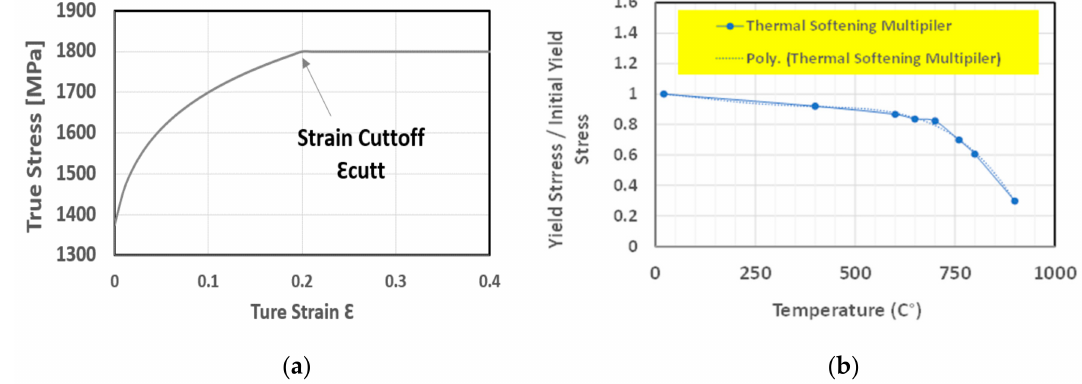
Figure 5. Inconel 718 Parameters for finite element model ( a ) Strain hardening behavior ( b ) Thermal softening